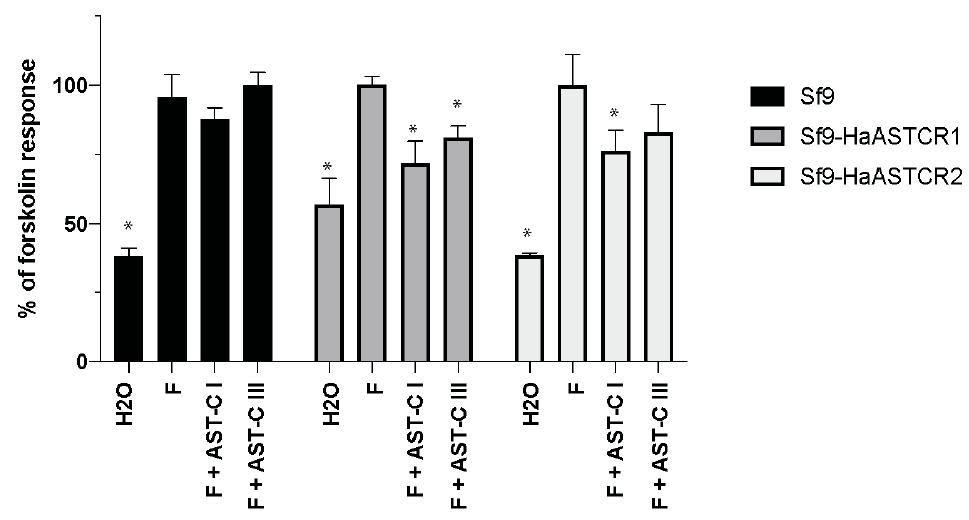
Figure 5. ASTCR1 and ASTCR2 are activated by AST-C peptides. Intracellular cAMP levels in Sf9 insect cells alone or stably expressing H. americanus ASTCR1 or 2 were measured via a cAMP ELISA kit following incubation with H 2 O alone, 10 µ M forskolin (F; adenylate cyclase activator), or forskolin + synthetic H. americanus AST-C I or AST-C III. Values have been normalized relative to the maximal forskolin response for each cell set. Bars represent mean +/- SEM values of cells assayed in triplicate. Asterisks (*) indicate values that are significantly different from the forskolin-activated response (ANOVA, with uncorrected Fisher’s LSD, p < 0.05; n = 4).